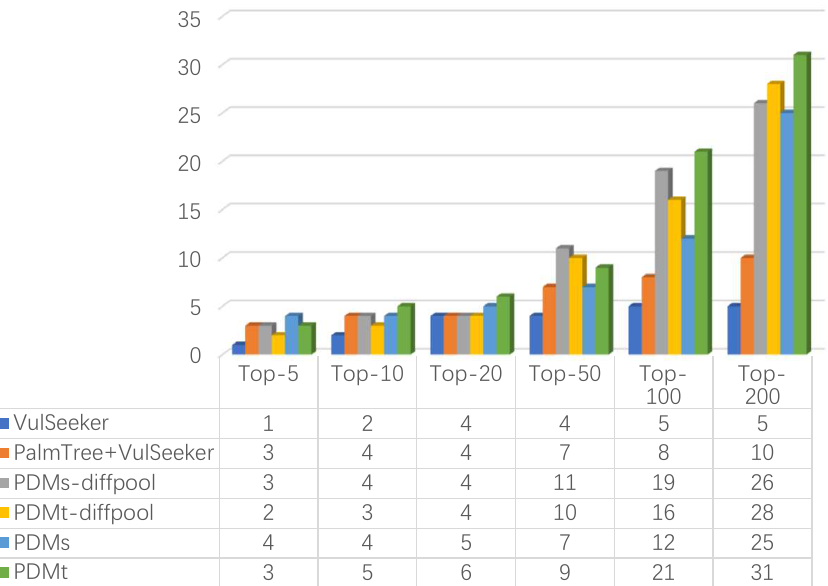
Figure 8. Vulnerability ranking compared with VulSeeker and PalmTree +